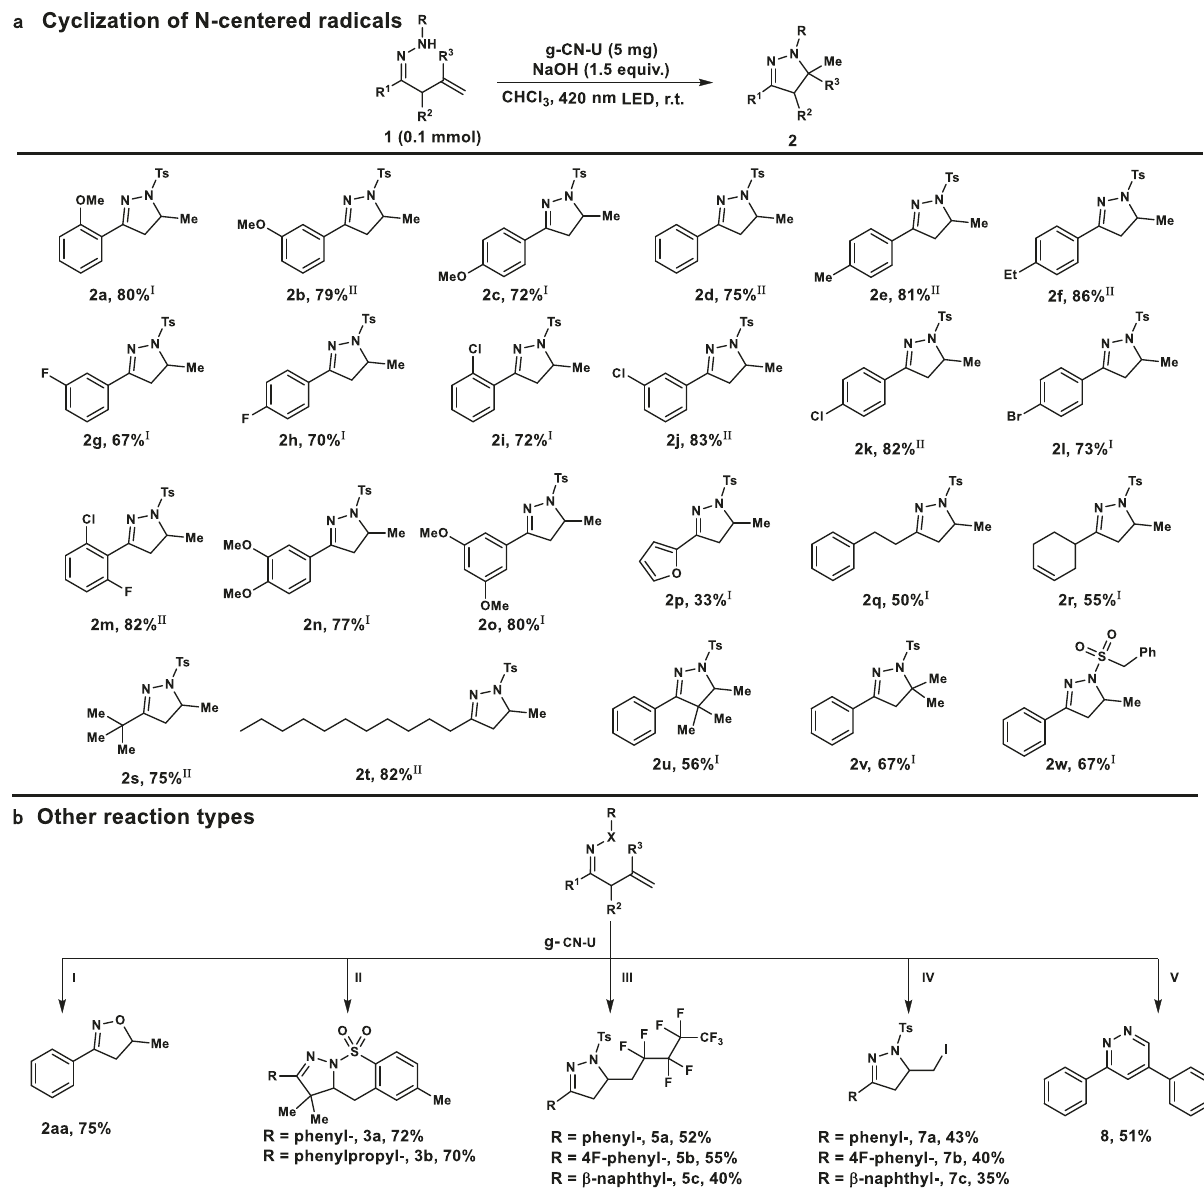
Fig. 5 | Substrate scope. a Substrate scope of β , γ -unsaturated hydrazones cycli- zation. Reaction conditions 1 (0.1mmol), I: NaOH or II: LiOH (1.5 equiv.), g-CN-U (5mg) in dry CHCl 3 (2mL) under N 2 at room temperature for 8 – 12h under a 3W